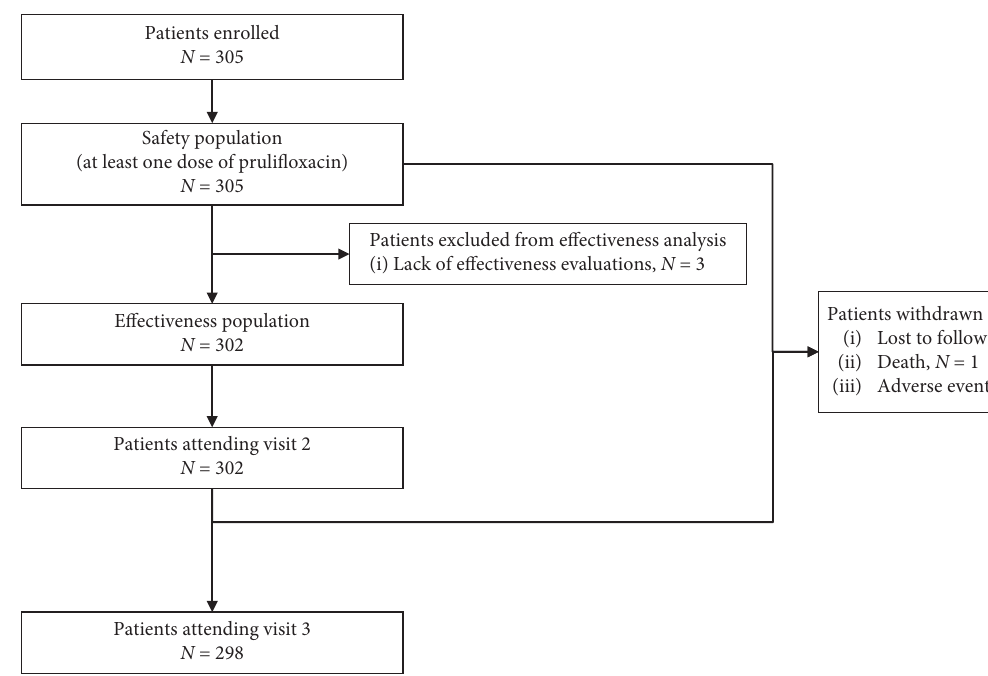
Figure 1: Patient